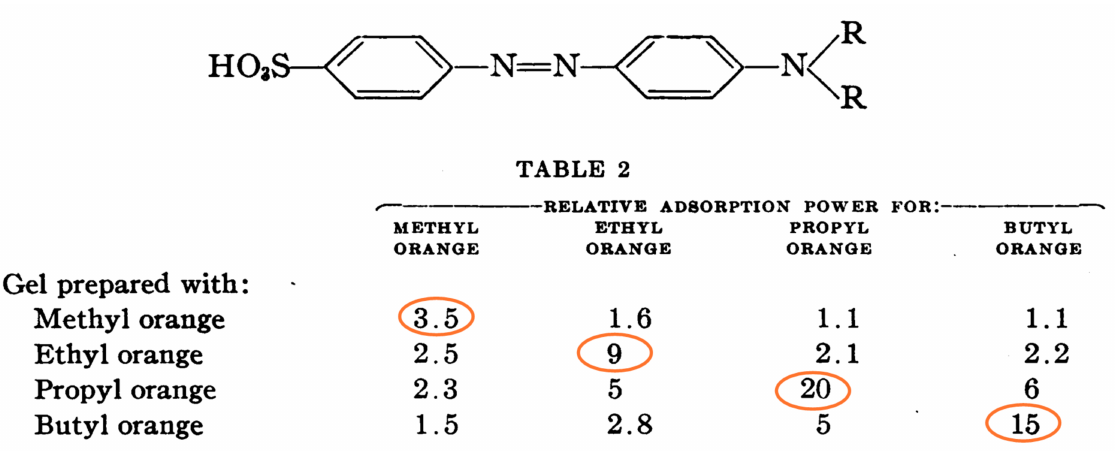
Figure 2. Screenshot of Dickey’s paper: Chemical structure of methyl orange and results of its relative adsorption (Adapted from [33]; paper in public